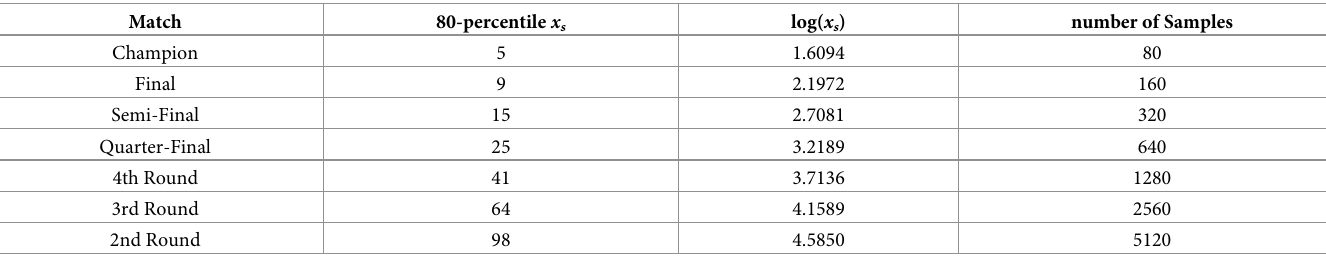
Table 1. 80-percentile rank for each round (male single,